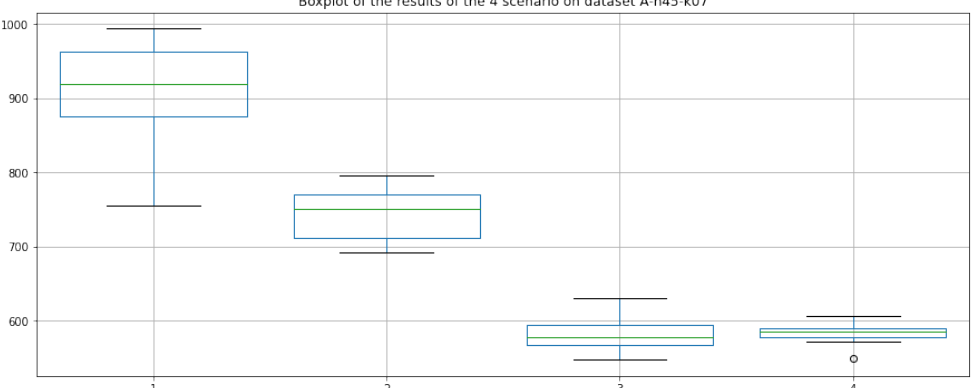
Figure 9. Boxplot of scenarios on the A-n39-k6 task of ABEFMP.